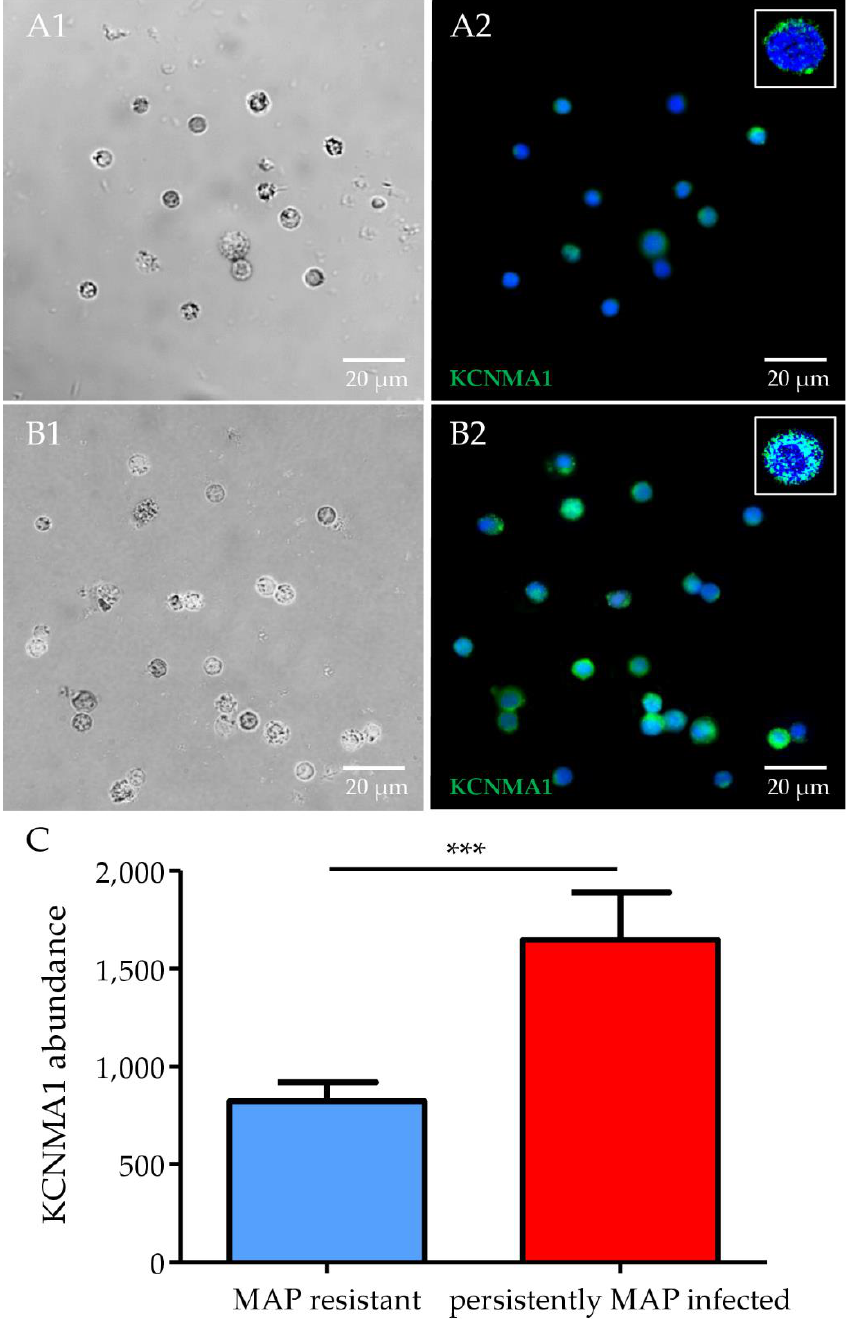
Figure 4. Higher abundance of KCNMA1 in PBMC of MAP-resistant compared with persistently MAP-infected cows. ( A1 ) Differential interference contrast (DIC) imaging of PBMC from MAP-resistant cows. ( A2 ) KCNMA1 (in green) in PBMC of MAP-resistant cows (nuclei stained with 4’,6- diamidino-2-phenylindole (DAPI)). ( B1 ) DIC of cells from persistently MAP-infected cows. ( B2 ) More KCNMA1 (in green) in persistently MAP-infected cows (all representative images). ( C ) Significantly higher KCNMA1 abundance in persistently MAP-infected cows than in MAP-resistant ones (quantified mean gray abundance from immunocytology ± SD, *** p ≤ 0.001). Image sizes are annotated by scale bar in lower right corner of respective image.